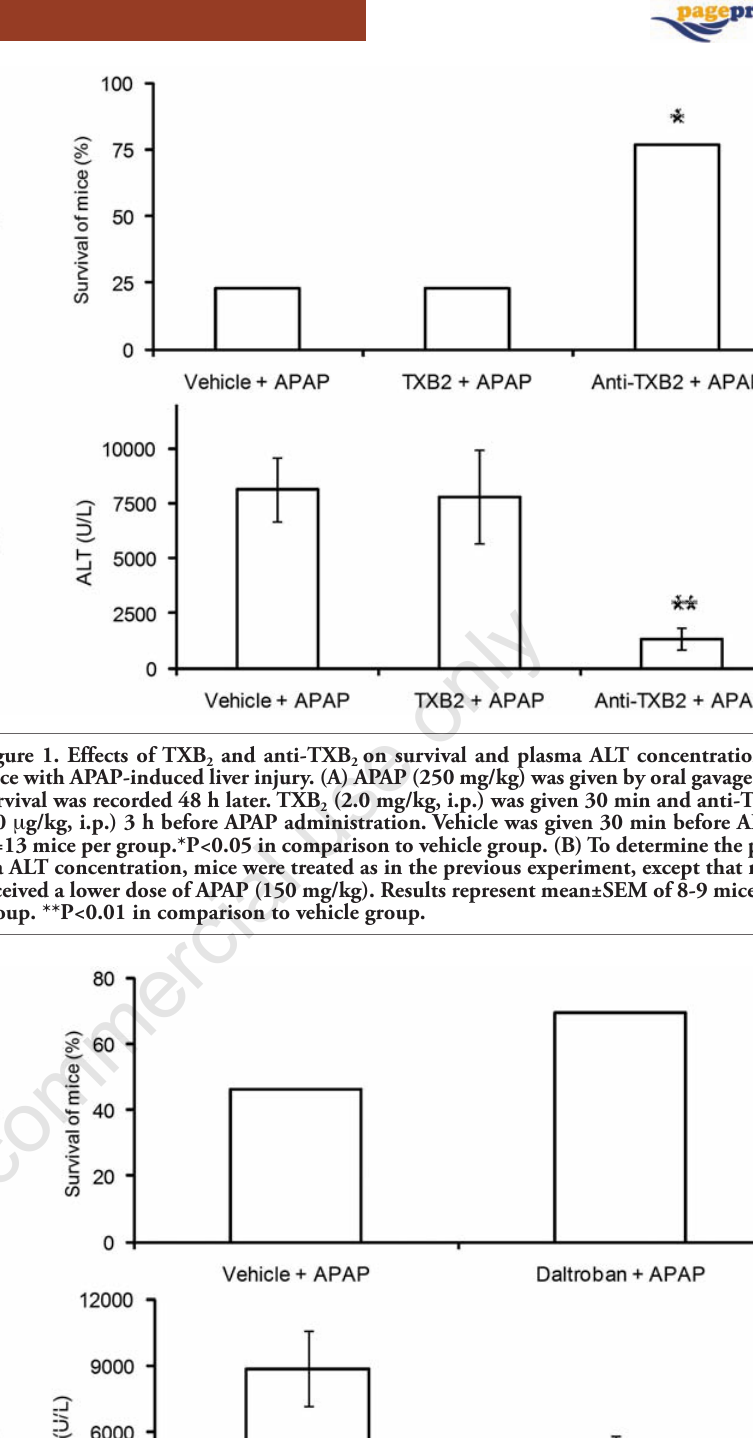
Figure 2. Effect of daltroban on survival and plasma ALT concentration in mice with APAP-induced liver injury. (A) APAP (300 mg/kg) was given by oral gavage and survival was recorded 48 h later. Daltroban (5.0 mg/kg, i.p.) and vehicle were given 30 min before APAP administration. N=13 mice per group. P>0.05 in comparison to vehicle group. (B) To determine the plasma ALT concentration, mice were treated as in the previous experi- ment, except that mice received a lower dose of APAP (150 mg/kg). Results represent mean±SEM of 8 mice per group. P>0.05 in comparison to vehicle